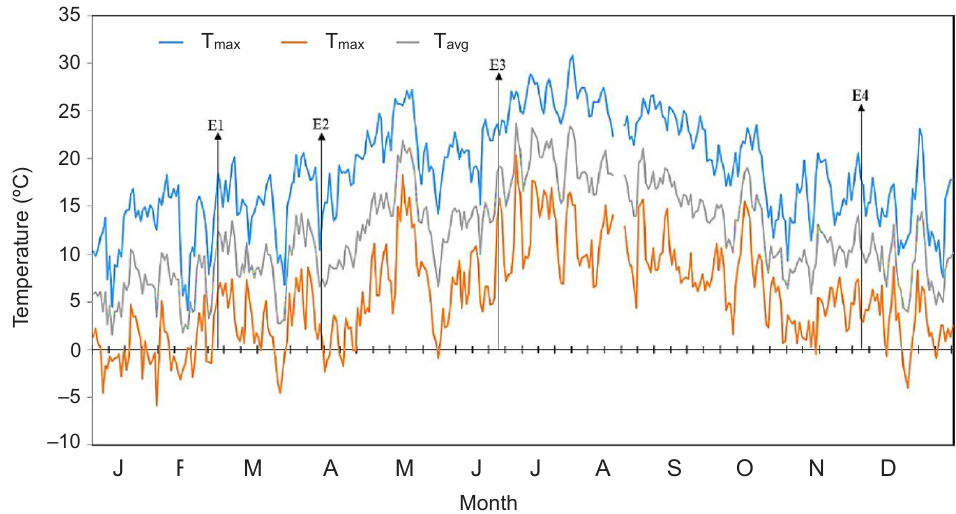
Figure 5. Daily temperature at Los Roques (2070 m a.s.l within the Teide National Park) in Tenerife, Canary Islands during the year of study. Daily mean and absolute minimum and maximum air temperature values are shown. Arrows highlight the sampling days for each experiment: E1, 23th of February (winter); E2, 8th of April (spring); E3 22nd of June (early summer); E4, 23rd of November (autumn).